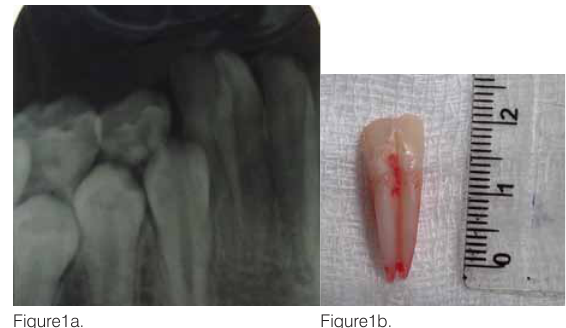
tooth.Figure1a. Figure1b. Figure1a. Case 1 (tab.1). Periapical radiograph. Figure1b. Case 1 (tab.1). Removed concrescent tooth 42 and supernumerary